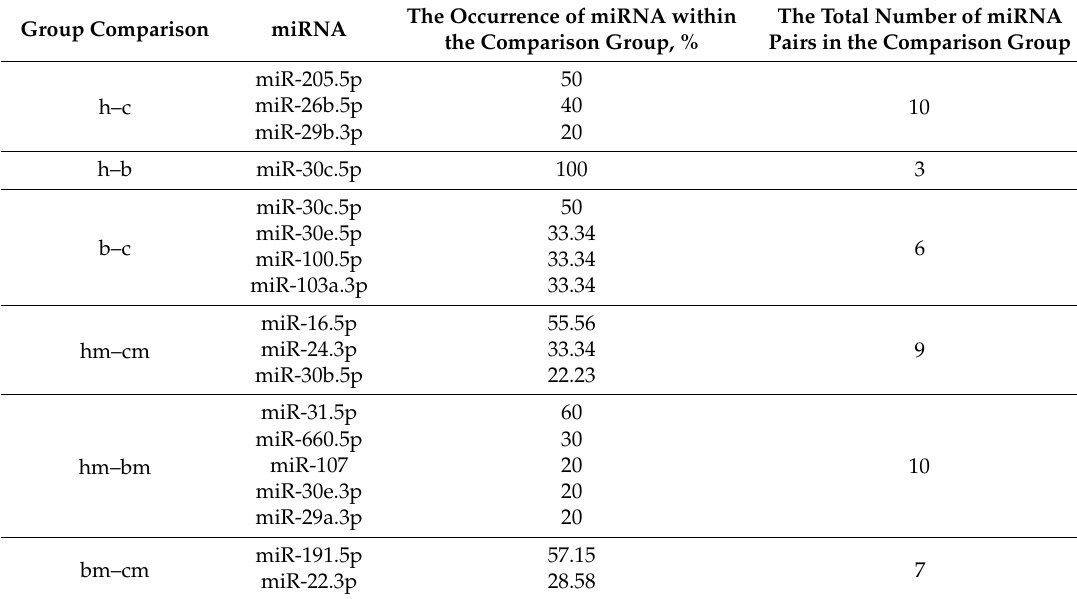
Table 3. The occurrence of miRNAs in group comparisons.